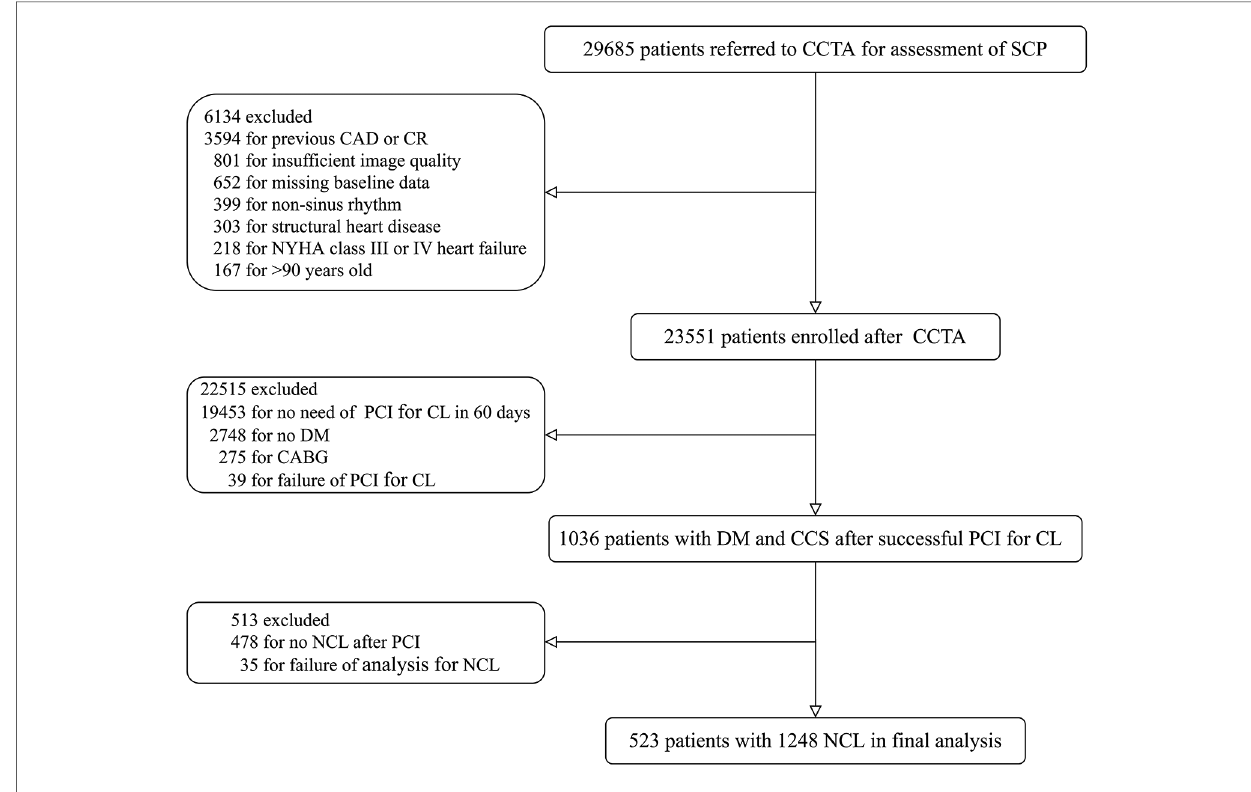
FIGURE 1 Consort